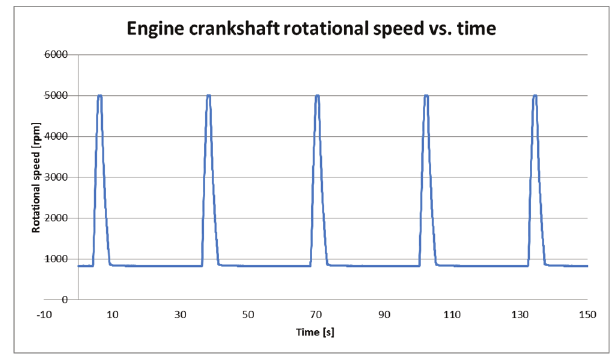
Fig. 2. Example of recorded data (engine crankshaft speed vs. time)